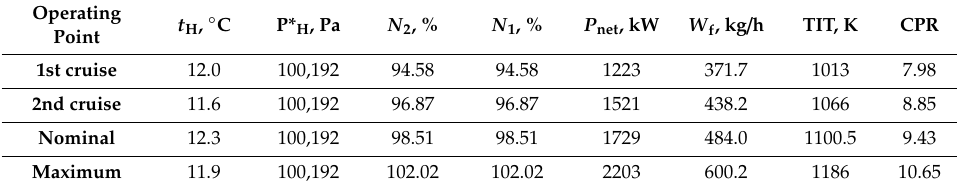
Table 7. Values of measured parameters determined by the corrected